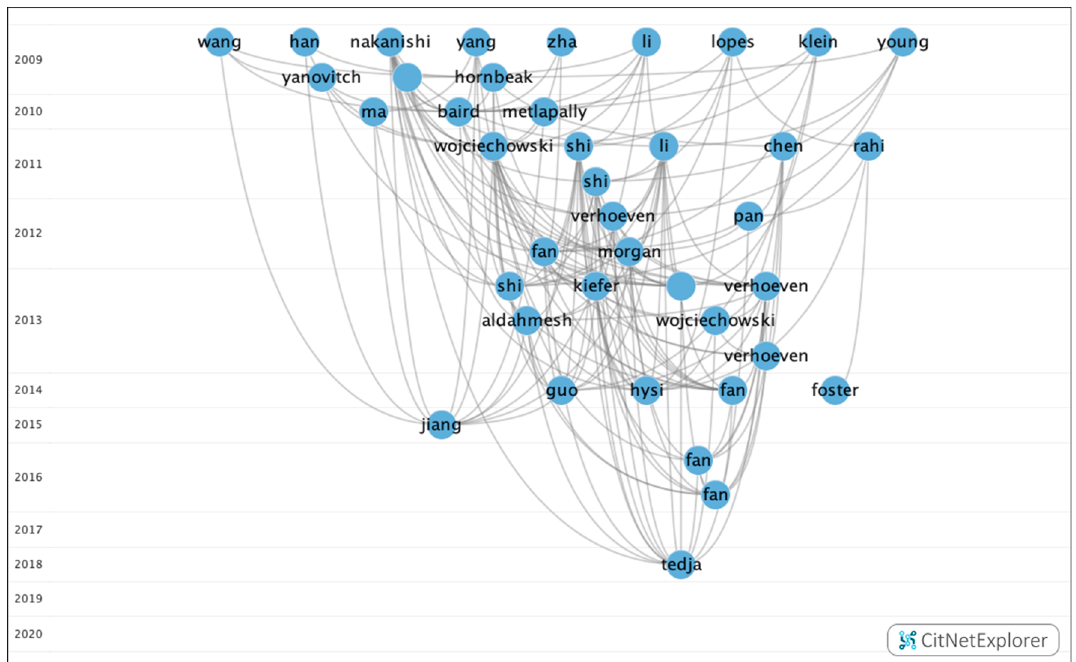
Figure 7. Citation network about genetic myopia.